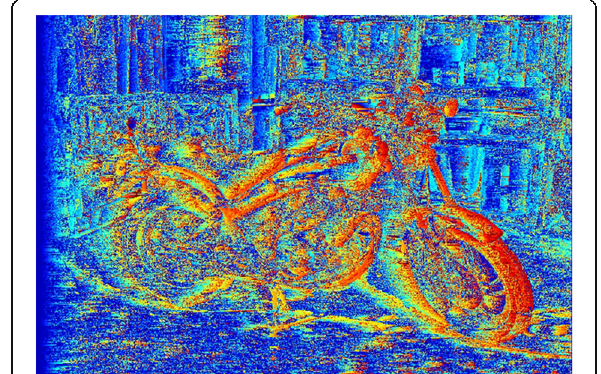
Fig. 3 Disparity image produced using the MD method. Overall object shape is visible in MD method output, but the image contains many noisy pixels. Incorrect pixels are visible on both